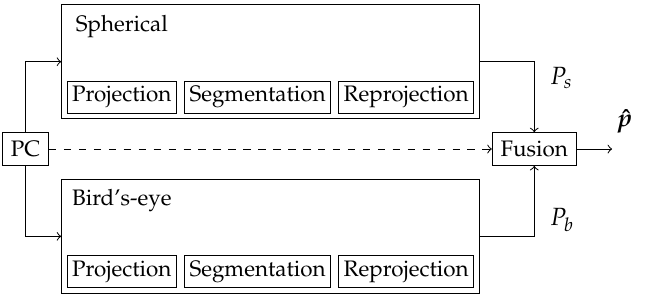
Figure 3. Basic architecture of combining different approaches. Each branch handles the whole process on its own. Only the prediction matrices for all points P s and P b are used within the fusion. Optionally, the coordinates of the points themselves can also be included in the